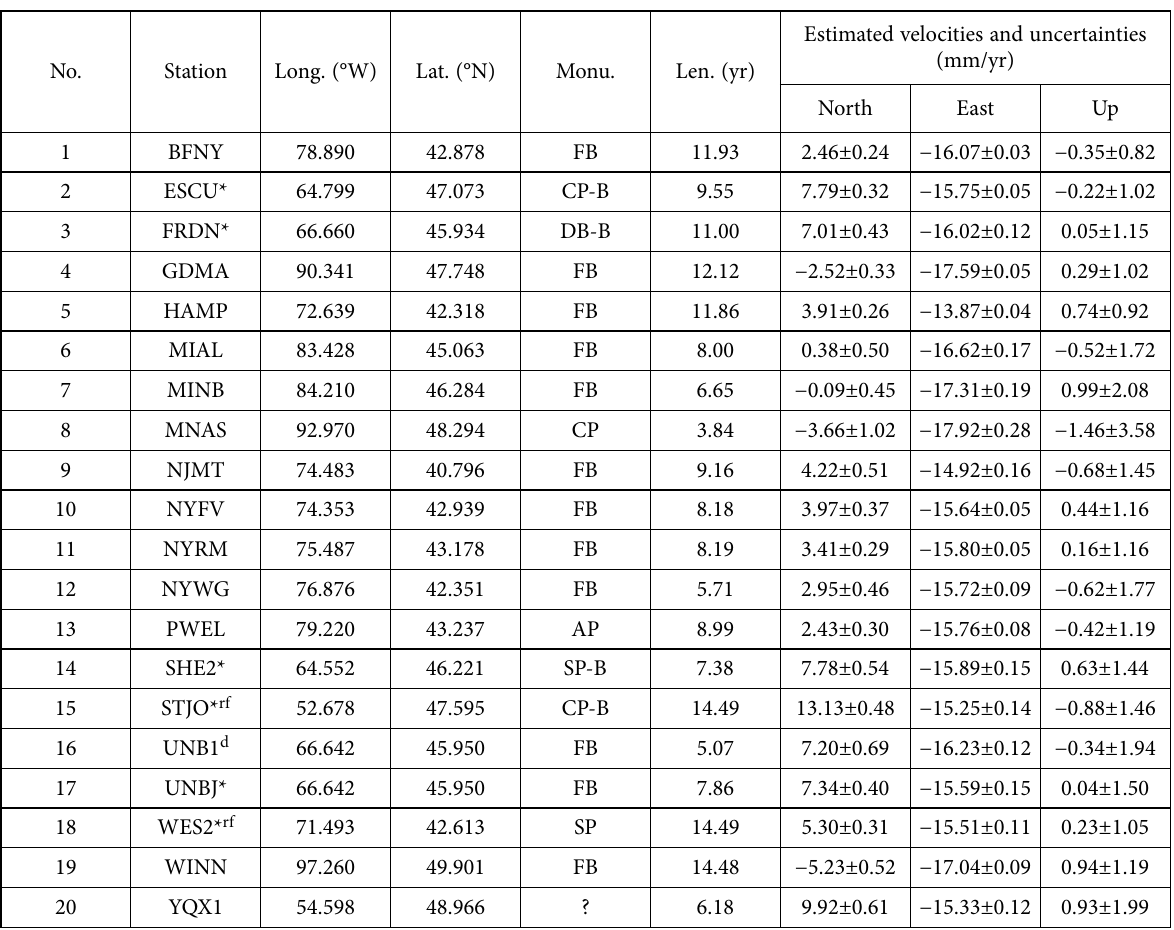
Table 1. The selected CGPS stations in eastern Canada for estimating the Euler’s pole of